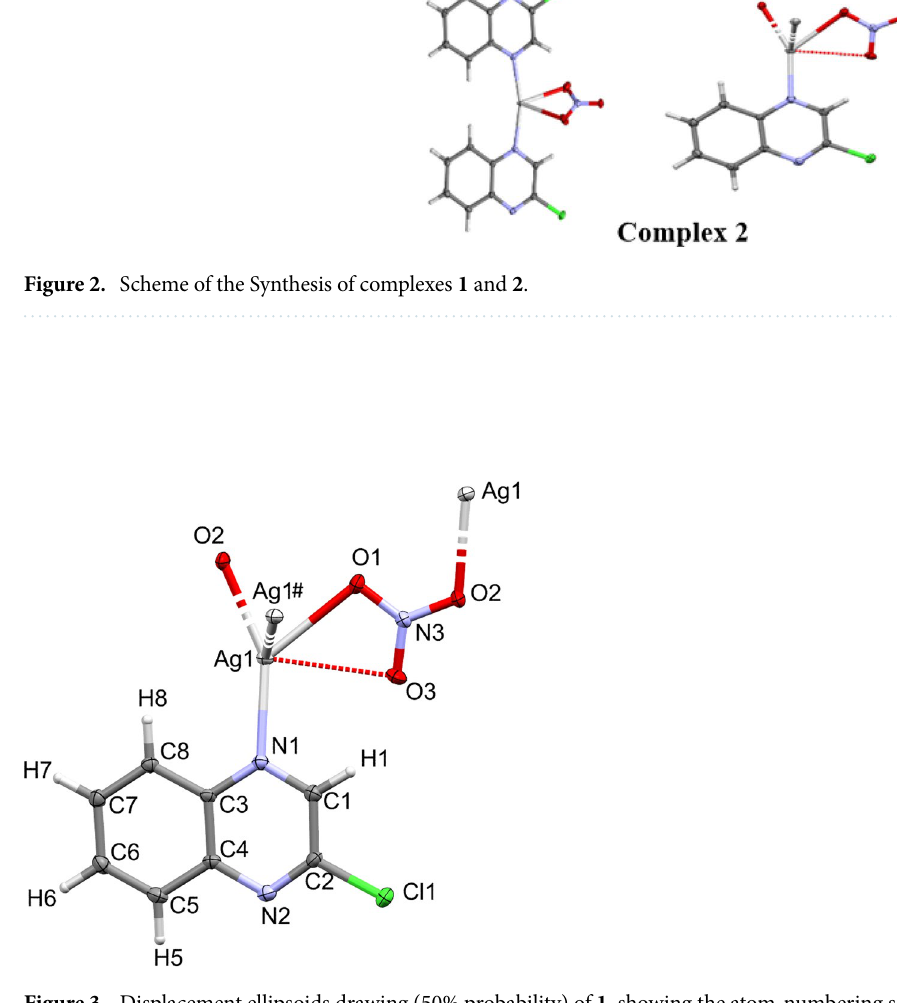
Figure 3. Displacement ellipsoids drawing (50% probability) of 1 , showing the atom-numbering scheme. The bonds, Ag1-O2 and Ag1–Ag1#, are shown with a broken line, because the O2 and Ag1# atoms belong to the neighboring monomer